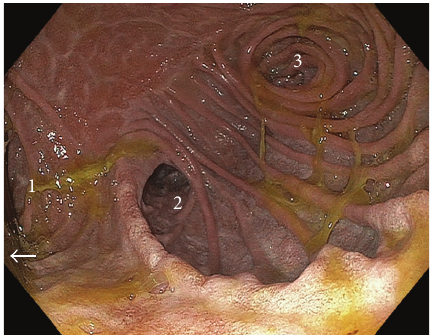
Figure 2: Preoperative endoscopic imaging. The second and third portions of the duodenum were noted to be markedly dilated with an accompanying finding of three downstream orifices. At this time, it was felt that the medial orifice (1) was the duplication and the lateralorifice(2)wasthetruelumenandthatorifice(3)representeda distal common channel. White arrow denotes area of biliopancreatic ampulla which was proximal to the